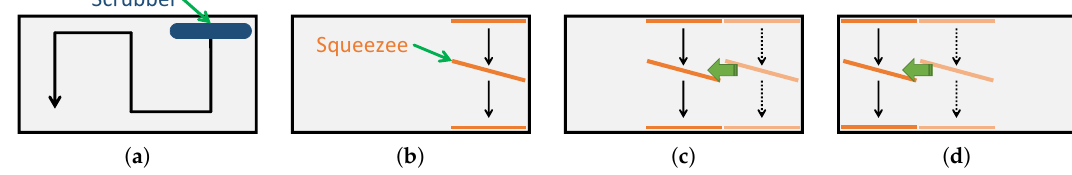
Figure 2. The cleaning strategy adopted by the experts. Firstly, the experts wash the dirt off by using the scrubber and cleaning liquid ( a ). Secondly, the dust residue is wiped by squeegee which is manipulated from top to bottom of the window ( b ). The wiping is done towards a single direction with respect to each column as shown as ( b ) → ( c ) → ( d